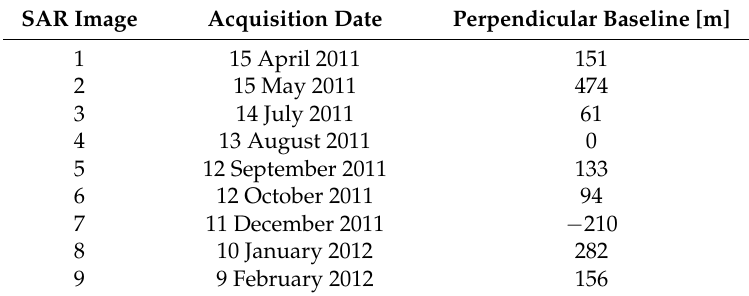
Table 2. Acquisition dates and perpendicular baselines with respect to the master of the Synthetic Aperture Radar (SAR) images from the “ENVISAT 2010+” project used in Advanced DInSAR (A-DInSAR) processing.